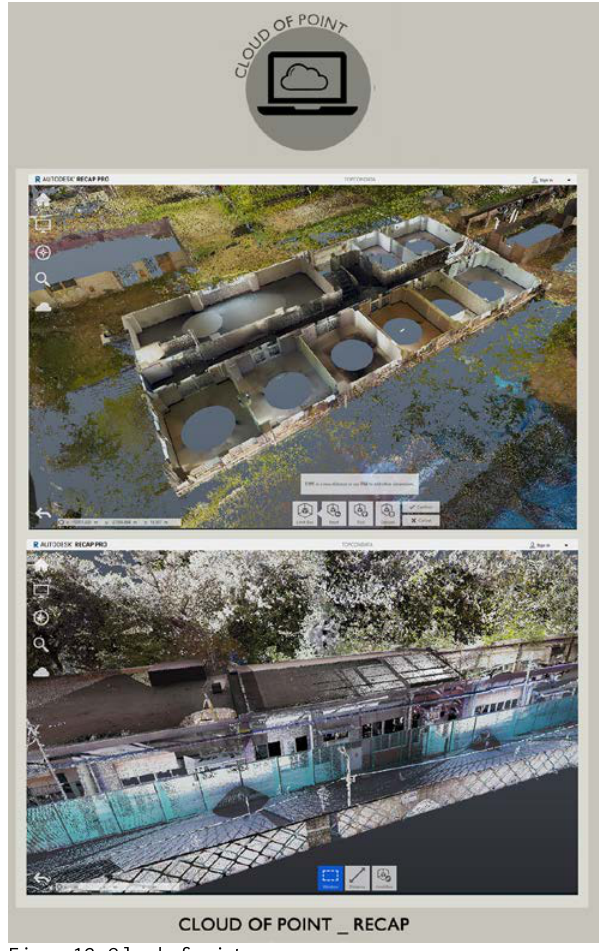
Figure 12: Cloud of point. The third one is merge them into one model, overlapping the hypothesized model and the cloud of point perfectly (Figure 13) (Baik, 2017).